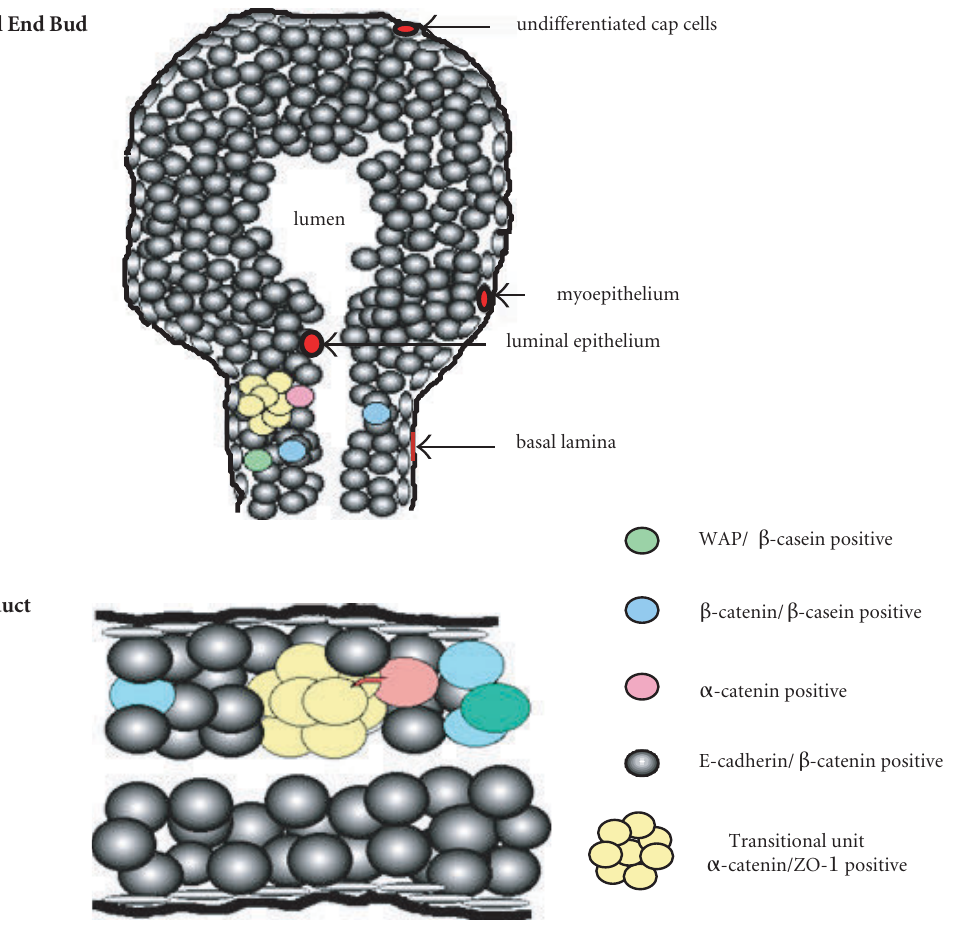
Figure 6: Model for transitional unit operation within the mammary duct. Shortly after puberty, estrous or nursing, stem cells or transit cells (yellow) committed to acquire additional differentiation markers are positioned within the unit. Positioning (morphogenic movement) cell-cell communication (acquisition of differentiation markers), or proliferation requires modulation of α -catenin, β -catenin, ZO-1 or E-cadherin expression and cytonemes (pink). Next,accumulation of differentiation markers, β -casein and E-cadherin are acquired (blue and gray), and finally, these cells become active secretory epithelium by expressing differentiation markers such WAP